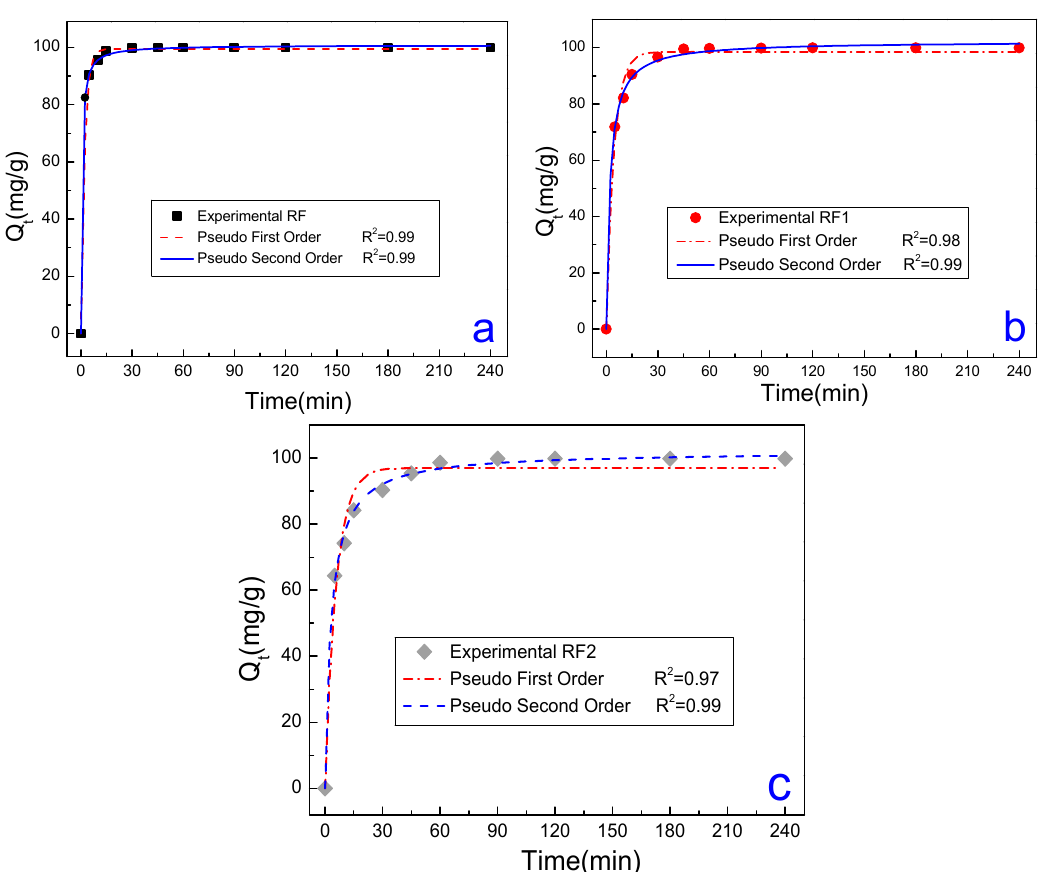
Figure 9. Kinetic graphs of MB in room temperature conditions, adsorbent mass 100 mg, fixating Ci in 50 mg/L: ( a ) adsorbent RF; ( b ) adsorbent RF1; and ( c ) adsorbent RF2.